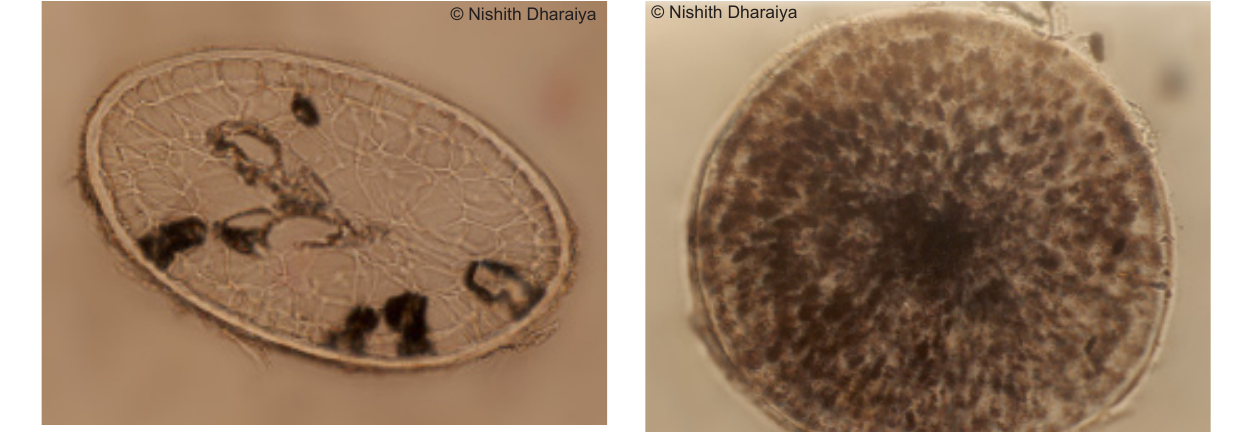
Image 3. Cross section of hair of Sambar